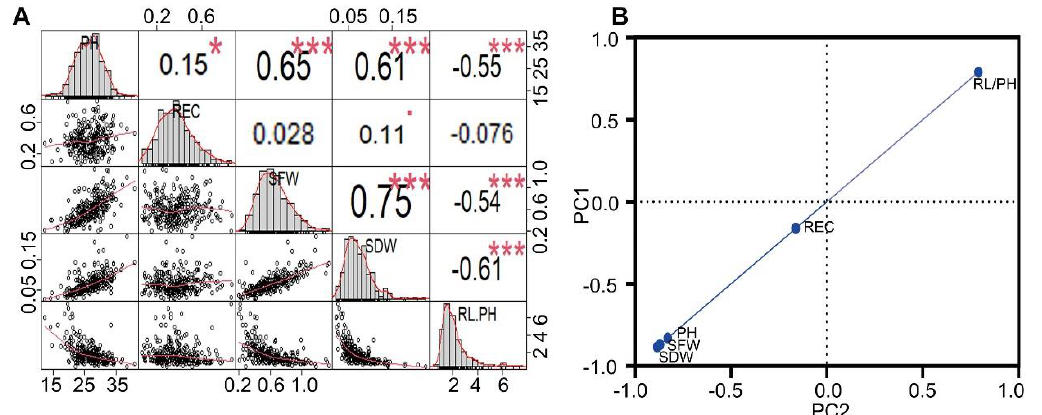
Figure 2. ( A ) A genetic analysis of phenotypic indexes of 289 F 2:3 populations under cold stress. ( B ) The phenotypic indices of 289 F 2:3 populations under low-temperature stress were analyzed by principal component analysis. Note: PH, SFW, SDW, REC, and RL represent plant height, seedling fresh weight, seedling dry weight, relative electrical conductivity, and root length, respectively. * indicates significance at 0.05 level, and *** indicates significance at 0.001 level. Table 1. Statistical analysis of phenotypic indicators of F 2:3 population (2 °C ; 5 d).